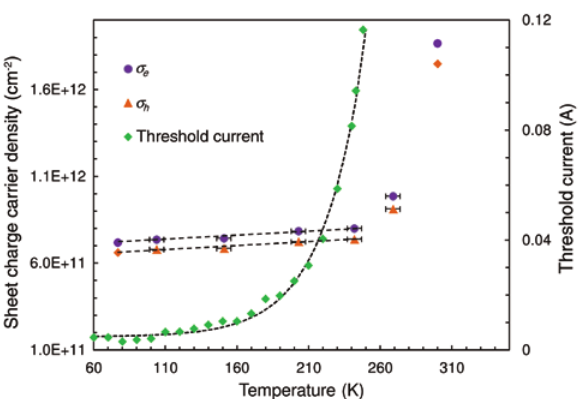
The doping profile across the active region of a